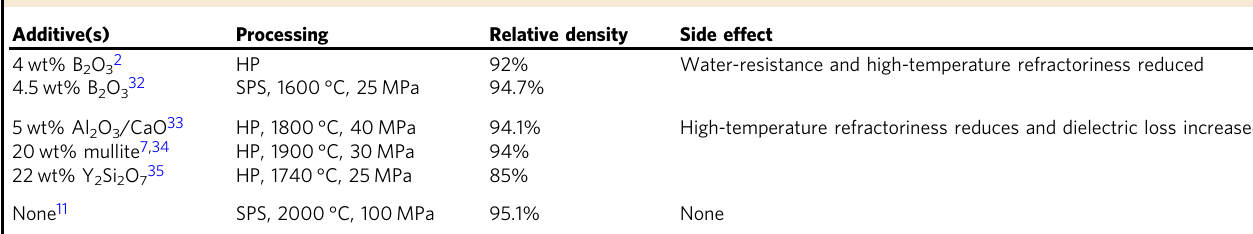
Table 1 hBN ceramics with different additives Additive(s) Processing Relative